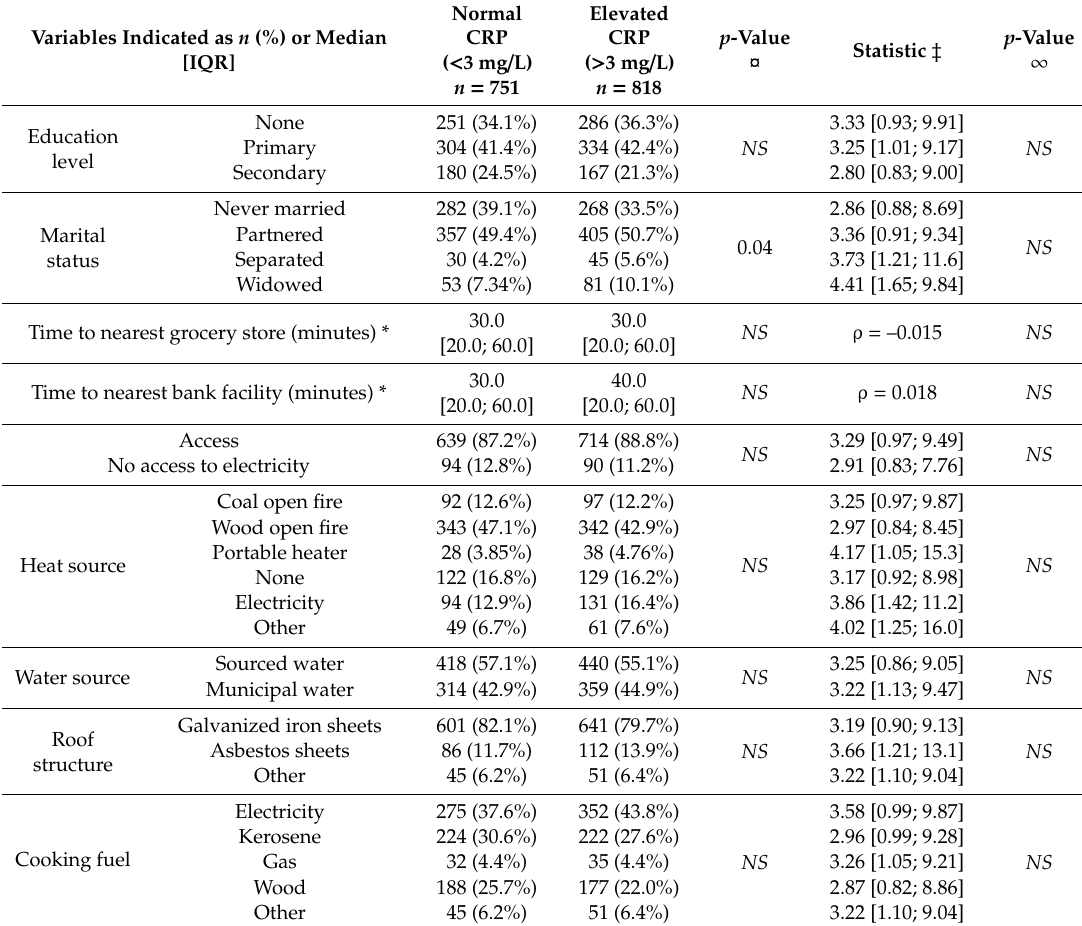
Table 2. Factors of socio-economic status (SES) stratified according to baseline CRP cut-o ff values for elevated cardiovascular disease (CVD)